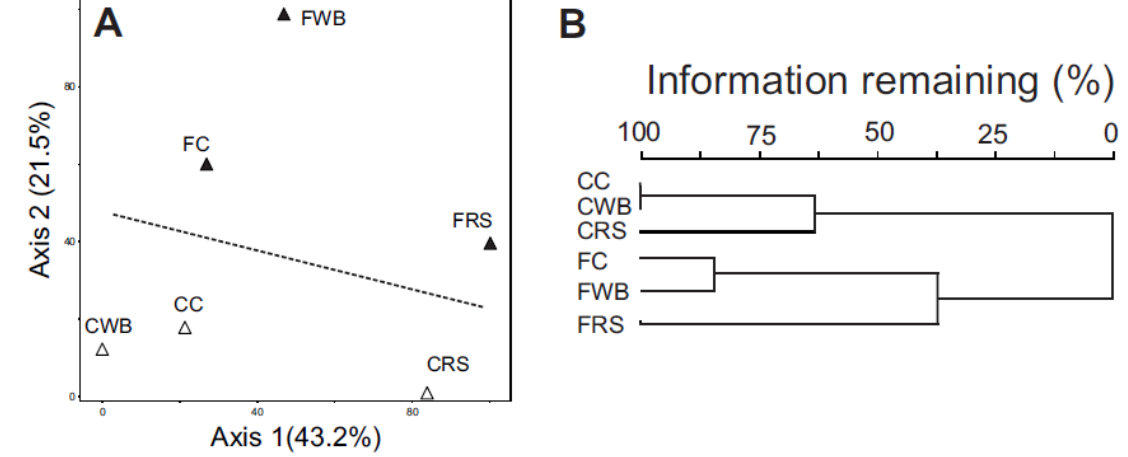
Figure 3. ( A ) MDS (PCoA) analysis of SEED gene assignments in the cecal (Δ) and fecal (▲) communities of rats fed each diet. Ordination plot was calculated using Euclidian distances and with resampling 1000 times. Axis 1: 43.2% of data variability, R 2 = 0.746, p = 0.0009. Axis 2: 21.5% of data variability, R 2 = 0.848, p = 0.0009; ( B ) Cluster analysis of SEED gene assignments. CC: cecal cellulose. FC: fecal cellulose. CWB: cecal wheat bran. FWB: fecal wheat bran. CRS: cecal resistant starch. FRS: fecal resistant